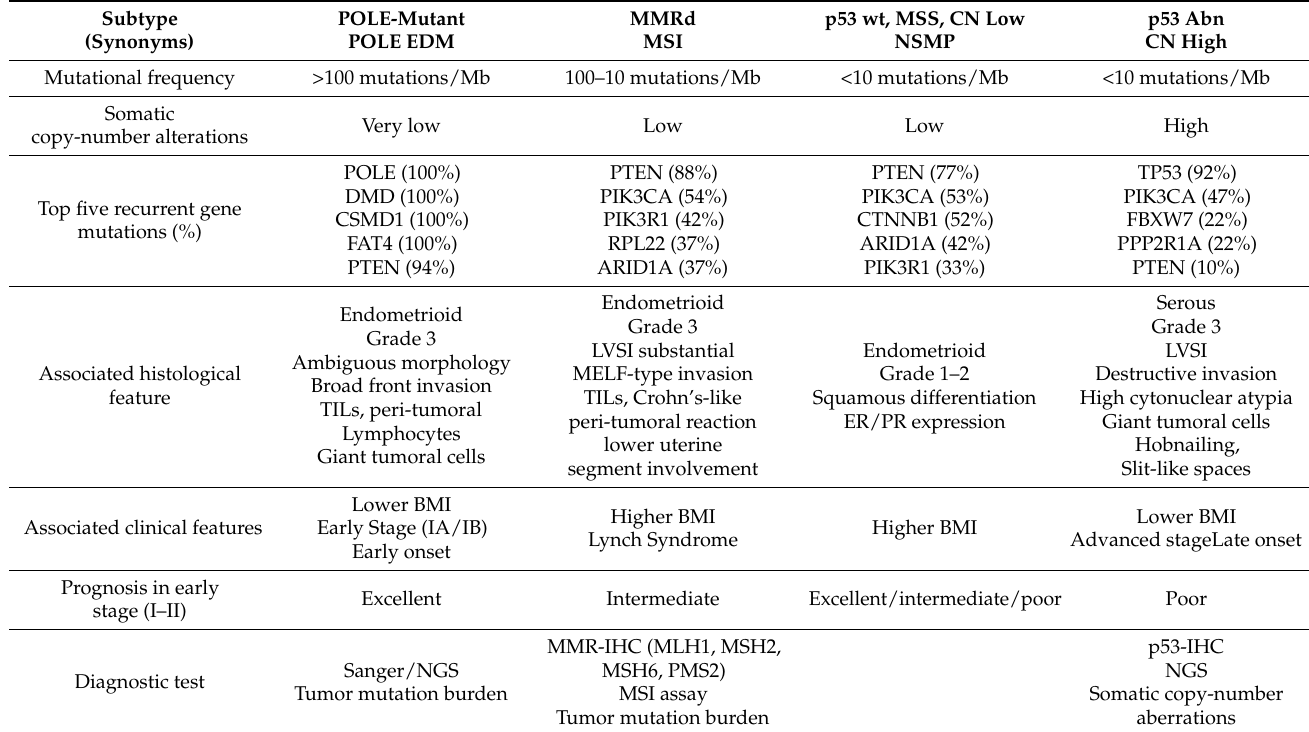
Table 2. Features of the four molecular subtypes. Adapted from